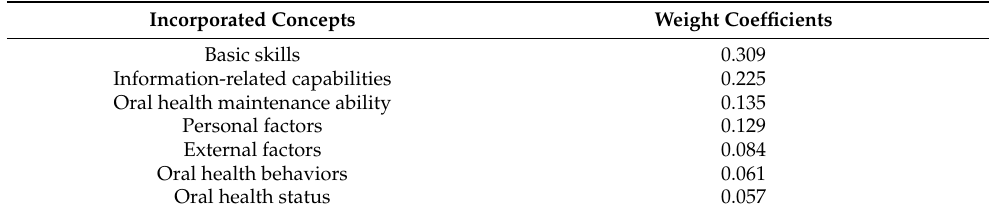
Table 4. OHL key concepts and their weight factors.